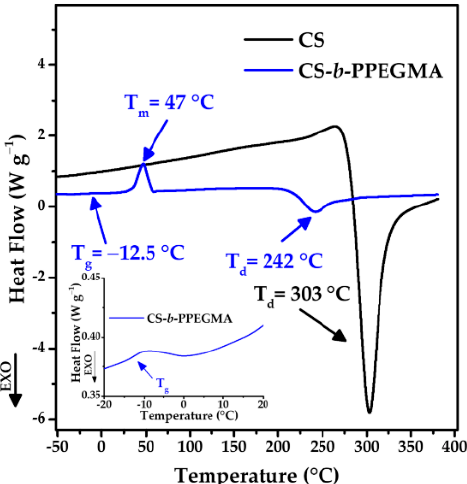
Figure 5. DSC thermograms of CS and CS- b -PPEGMA.